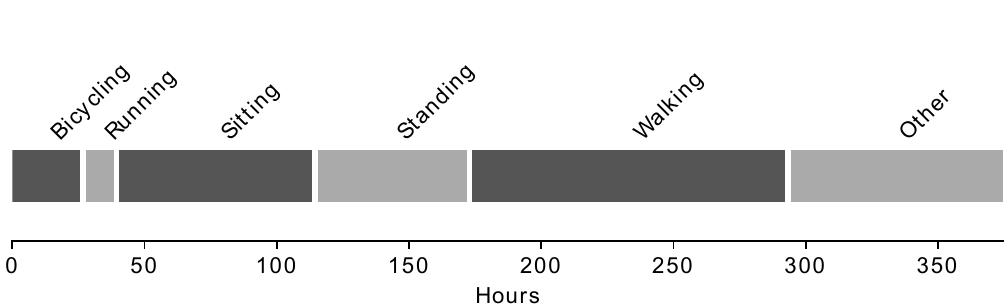
Figure 2. Composition of data in the Human Gait Database. All dimensions of all sensors are counted, i.e., one minute of subject testing generates 36 min of sensor data. “Other” activities consist of walking up and downs stairs, standing up, sitting down, standing on an elevator, and sitting in a